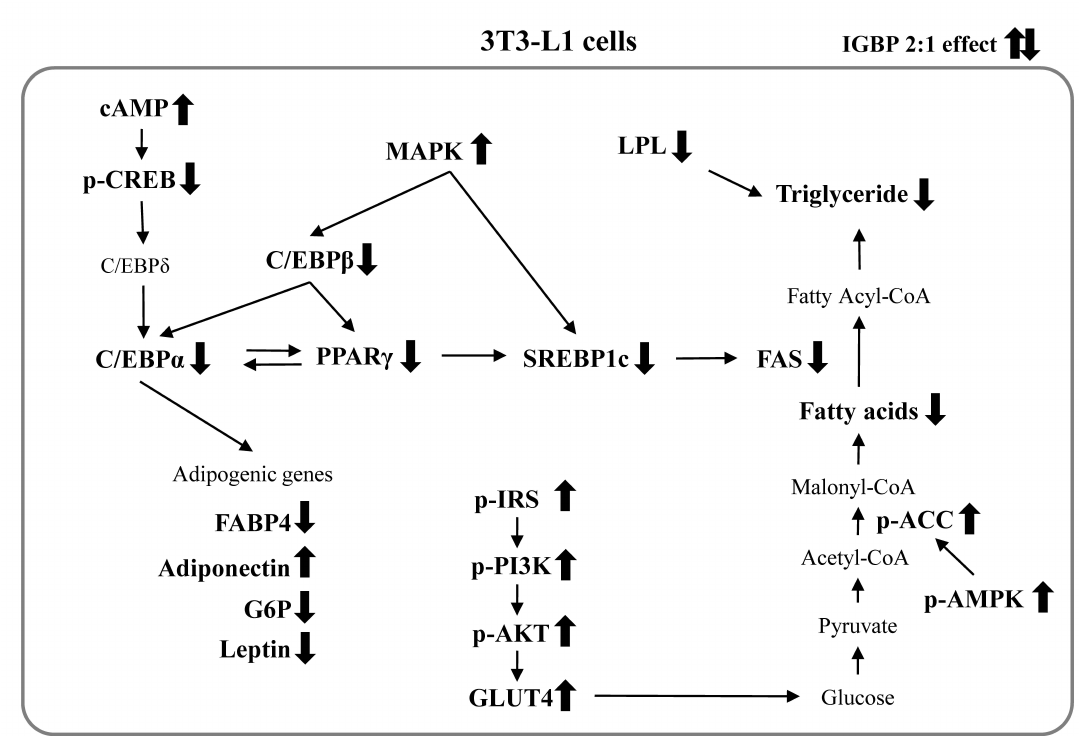
Figure 6. E ff ects of the IGBP 2:1 mixture on the adipogenesis and lipogenesis mechanisms in 3T3-L1 adipocytes. cAMP, cyclic adenosine monophosphate; MAPK, mitogen-activated protein kinase; C / EBP, CCAAT / enhancer-binding protein; PPAR γ , peroxisome proliferator-activated receptor gamma; FABP4, fatty-acid-binding protein 4; G6Pase, glucose 6-phosphatase; SREBP1c, sterol regulatory element-binding protein-1c; IRS1, insulin receptor substrate-1; PI3K, phosphoinositide 3-kinase; AKT, protein kinase B; GLUT4, glucose transporter type 4; AMPK, AMP-activated protein kinase; ACC, acetyl coenzyme A carboxylase; FAS, fatty acid synthase; LPL, lipoprotein